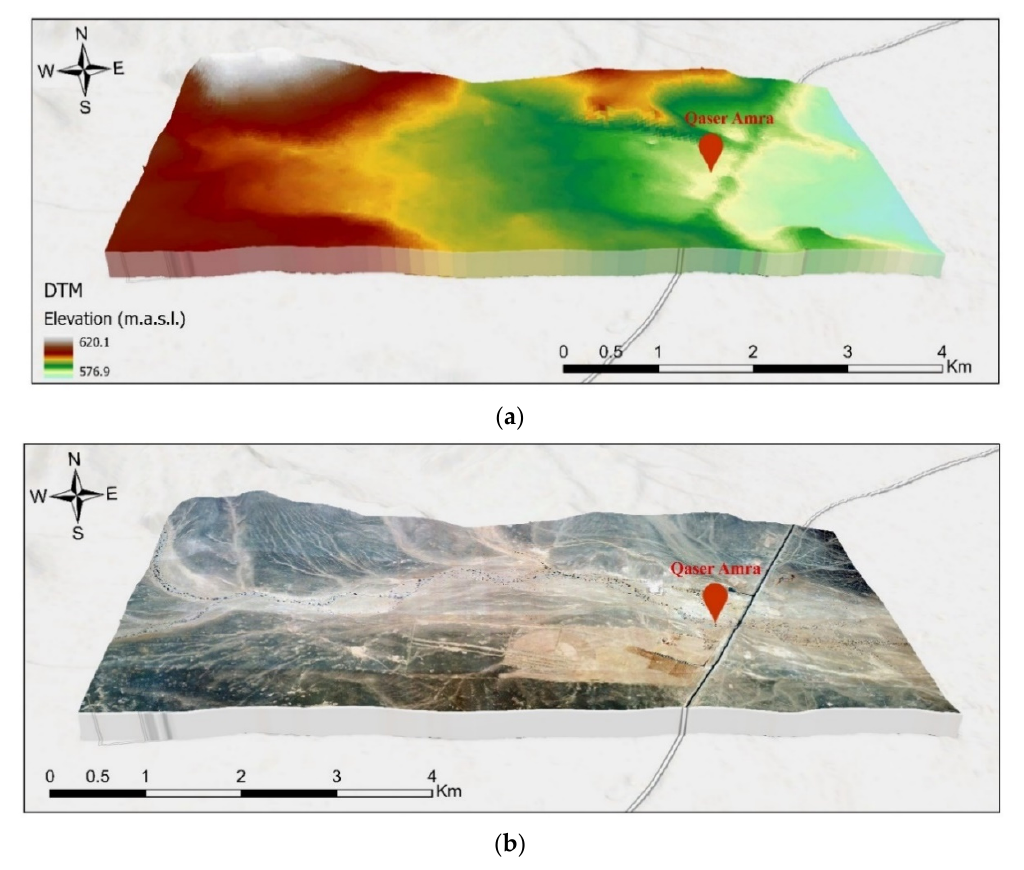
Figure 13. 2.5D Geo-referenced model: ( a ) 3D digital elevation model (DEM); ( b ) 3D orthophoto.